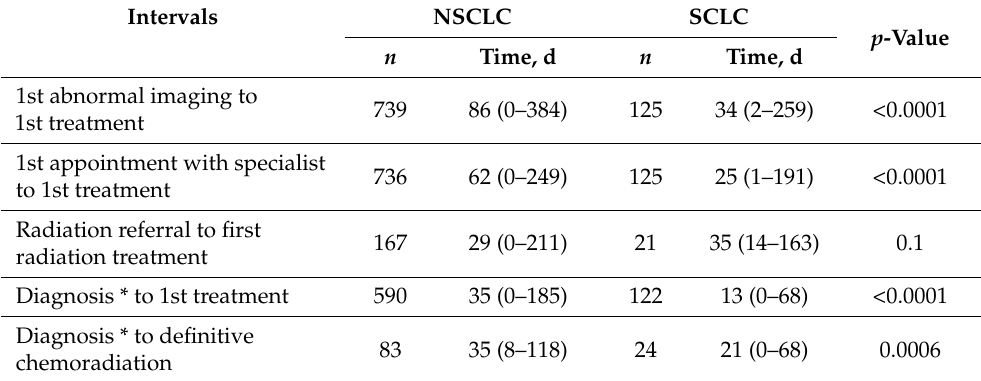
Table A2. Wait times for investigation and treatment, NSCLC versus SCLC.